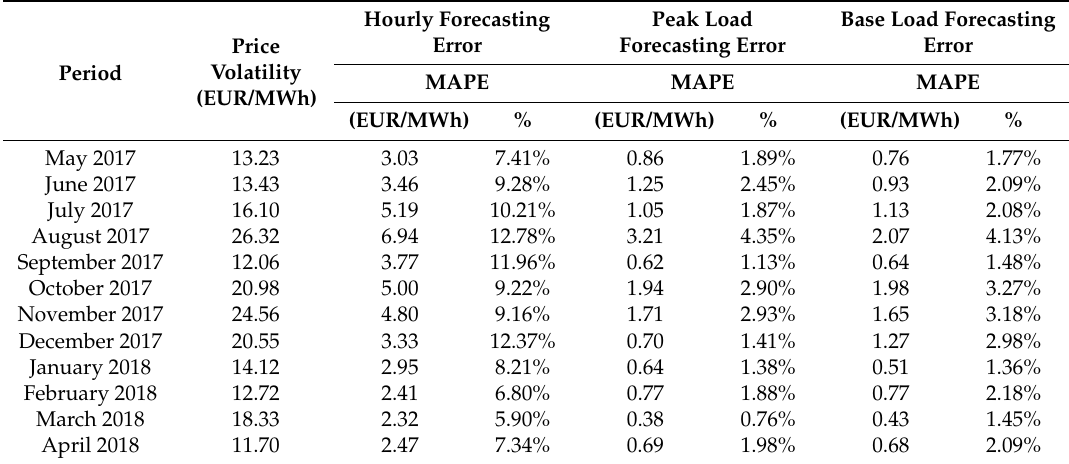
Table 4. Simulation results for electricity price forecast calculated with the similar day method in 2nd forecasting interval.